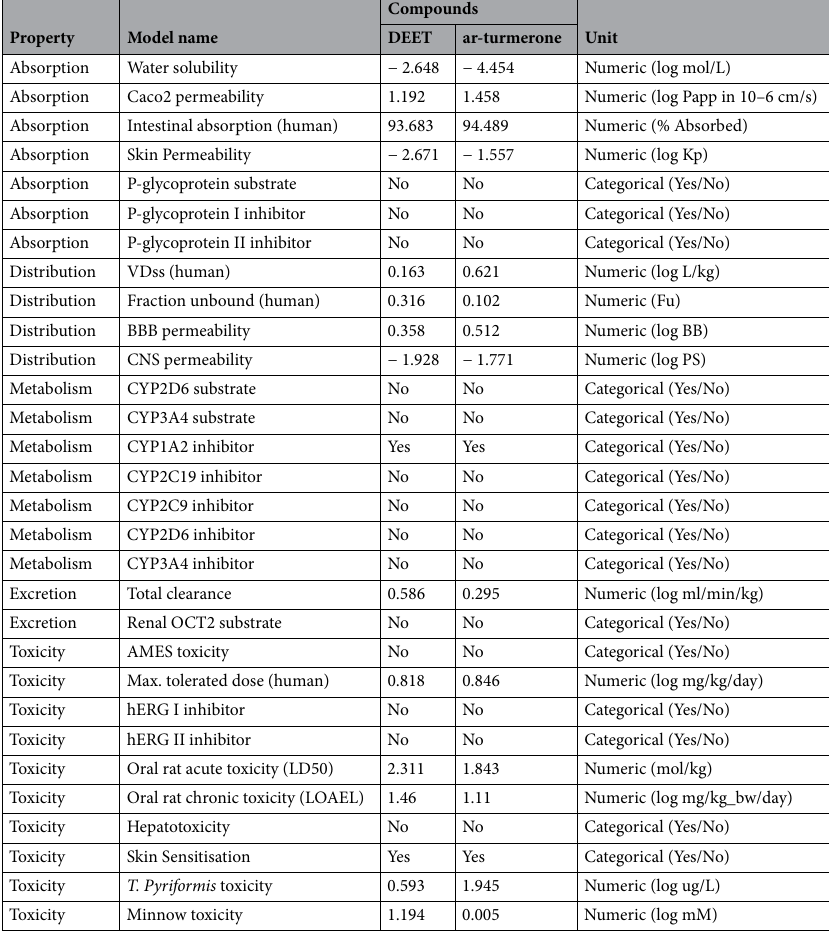
Table 3. The ADMET properties of compounds under